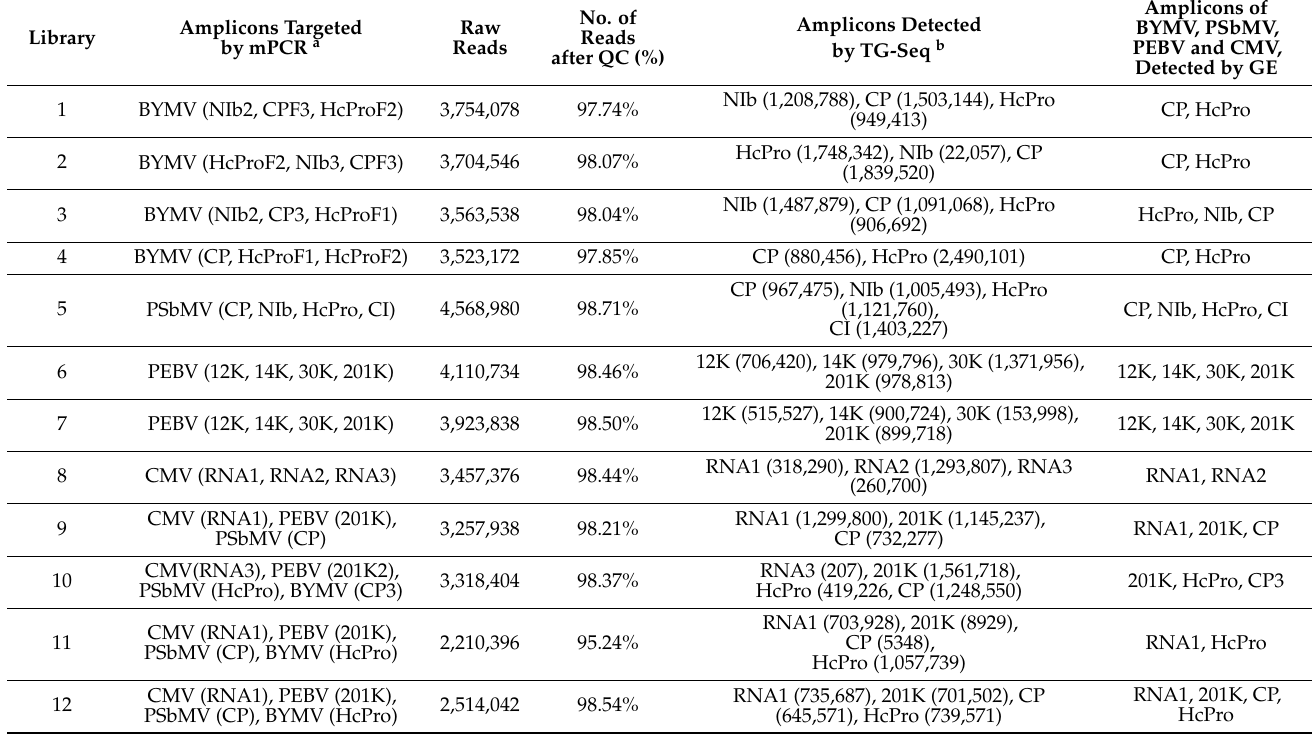
Table 3. A comparison between targeted genome sequencing (TG-Seq) and gel electrophoresis (GE) to detect BYMV, PSbMV, PEBV and CMV amplicons generated in a multiplex PCR (mPCR)